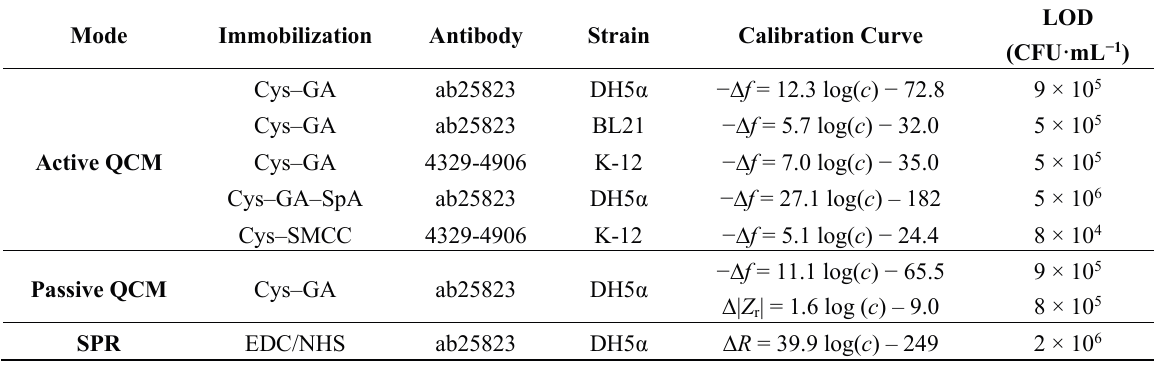
Table 1. Summary of the results for tested QCM and SPR immunosensors and E. coli strains.